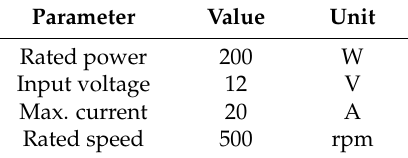
Figure 8. Experiment setup. Table 1. Motor parameters.